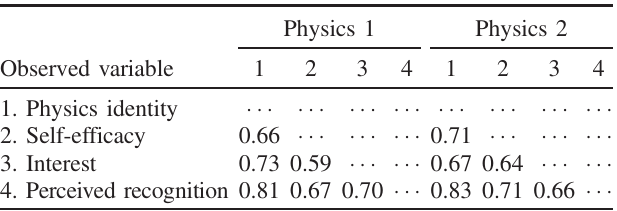
TABLE II. Zeroth order correlation coefficients of the con- structs in the mediation